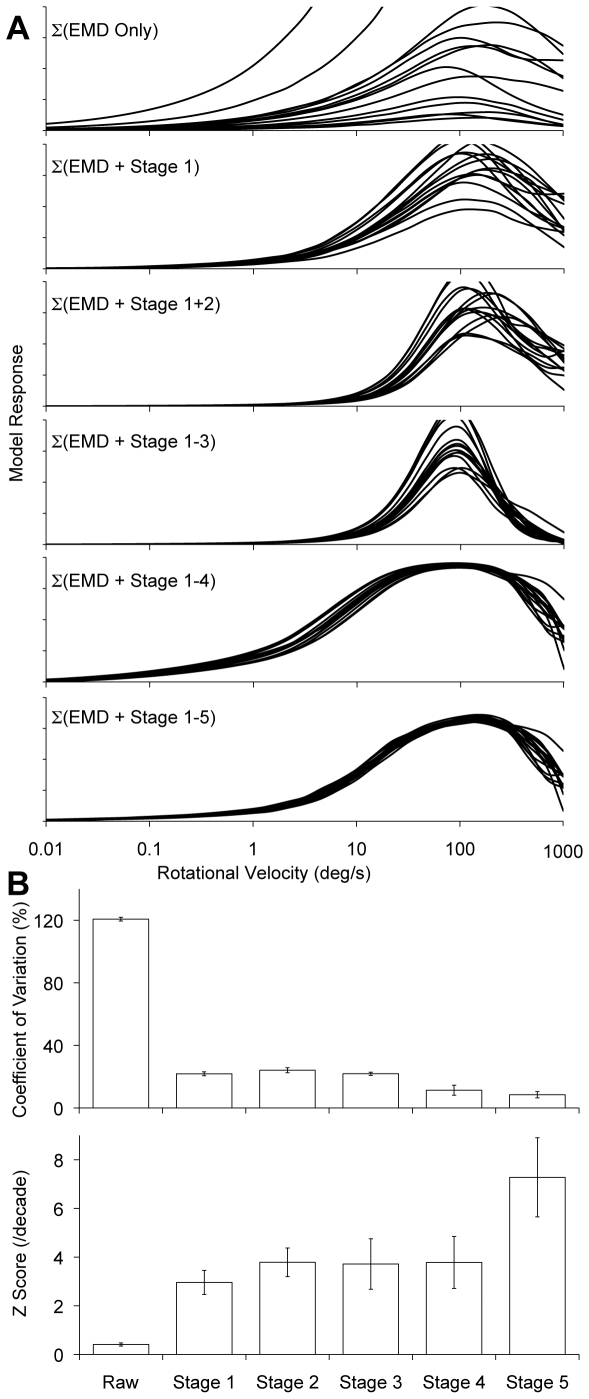
Model responses after various processing stages.A) Steady-state responses, integrated over the entire image, of the model to all 14 input images over the range of velocities tested after inclusion of various modeling stages as depicted in Figure 2. Lines are color coded to the images as shown in Figure 1. B) Summary statistics of model performance after each stage of processing. All data are given as mean of responses over the range 0.1–100 degrees/s. Error bars represent 95% confidence intervals. The inclusion of each of the stages improved the ability of the model to reliably encode velocity by reducing the variability in the response between images. Σ illustrated that the responses were summed over all space, EMD stands for correlational elementary motion detector and was the fundamental motion estimation operation. For a detailed description of the processing of each stage, and the exact effects on velocity consistency between images, see main text.